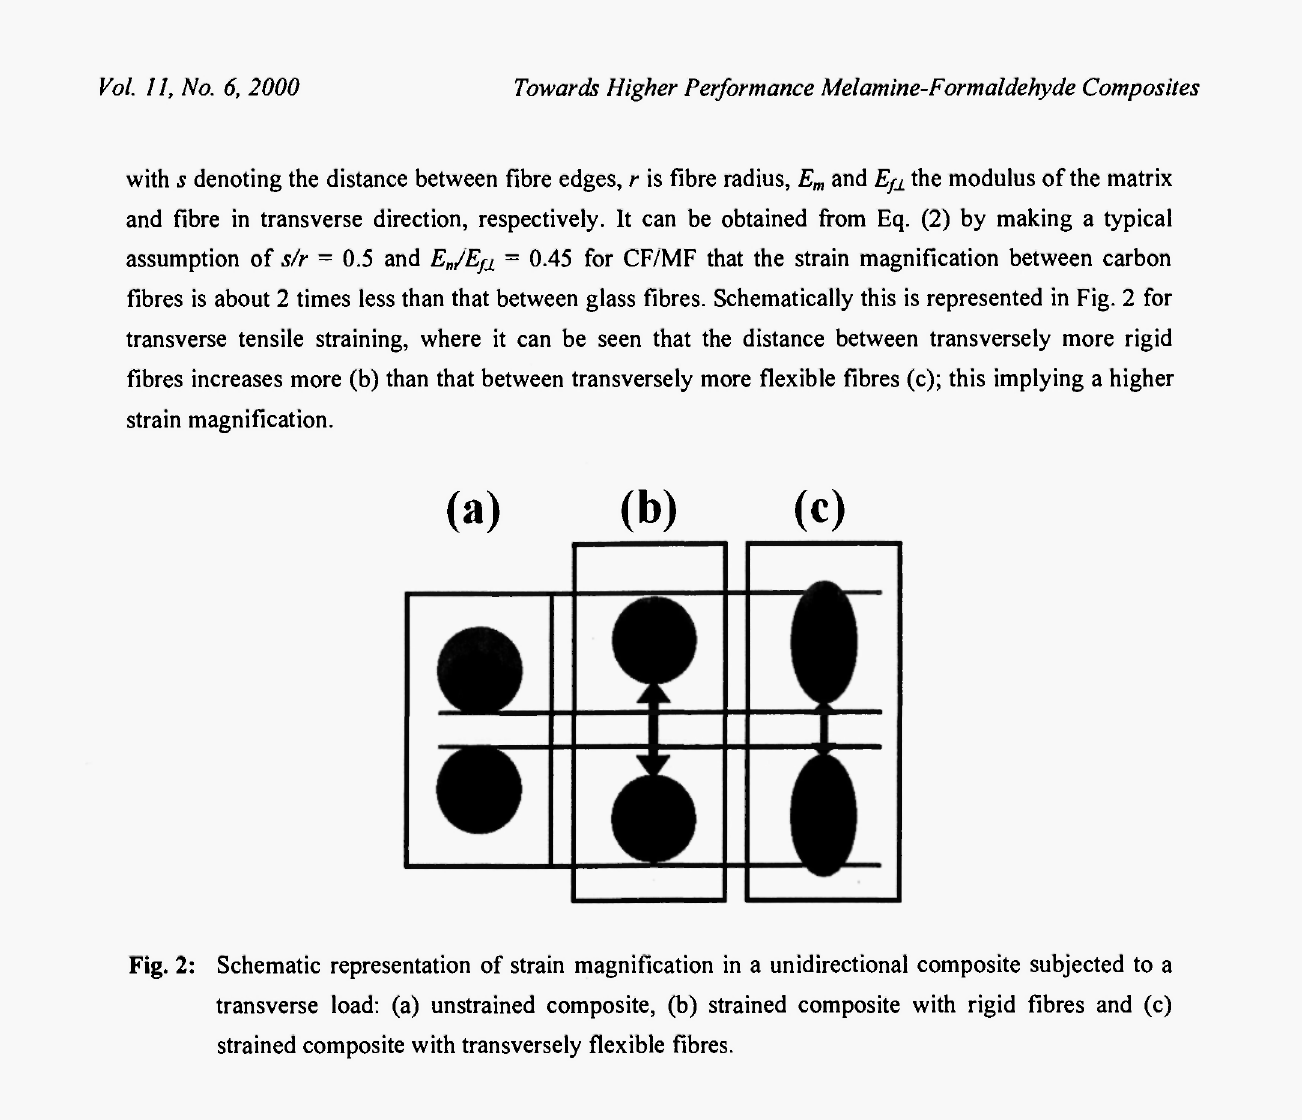
Fig. 2: Schematic representation of strain magnification in a unidirectional composite subjected to a transverse load: (a) unstrained composite, (b) strained composite with rigid fibres and (c) strained composite with transversely flexible